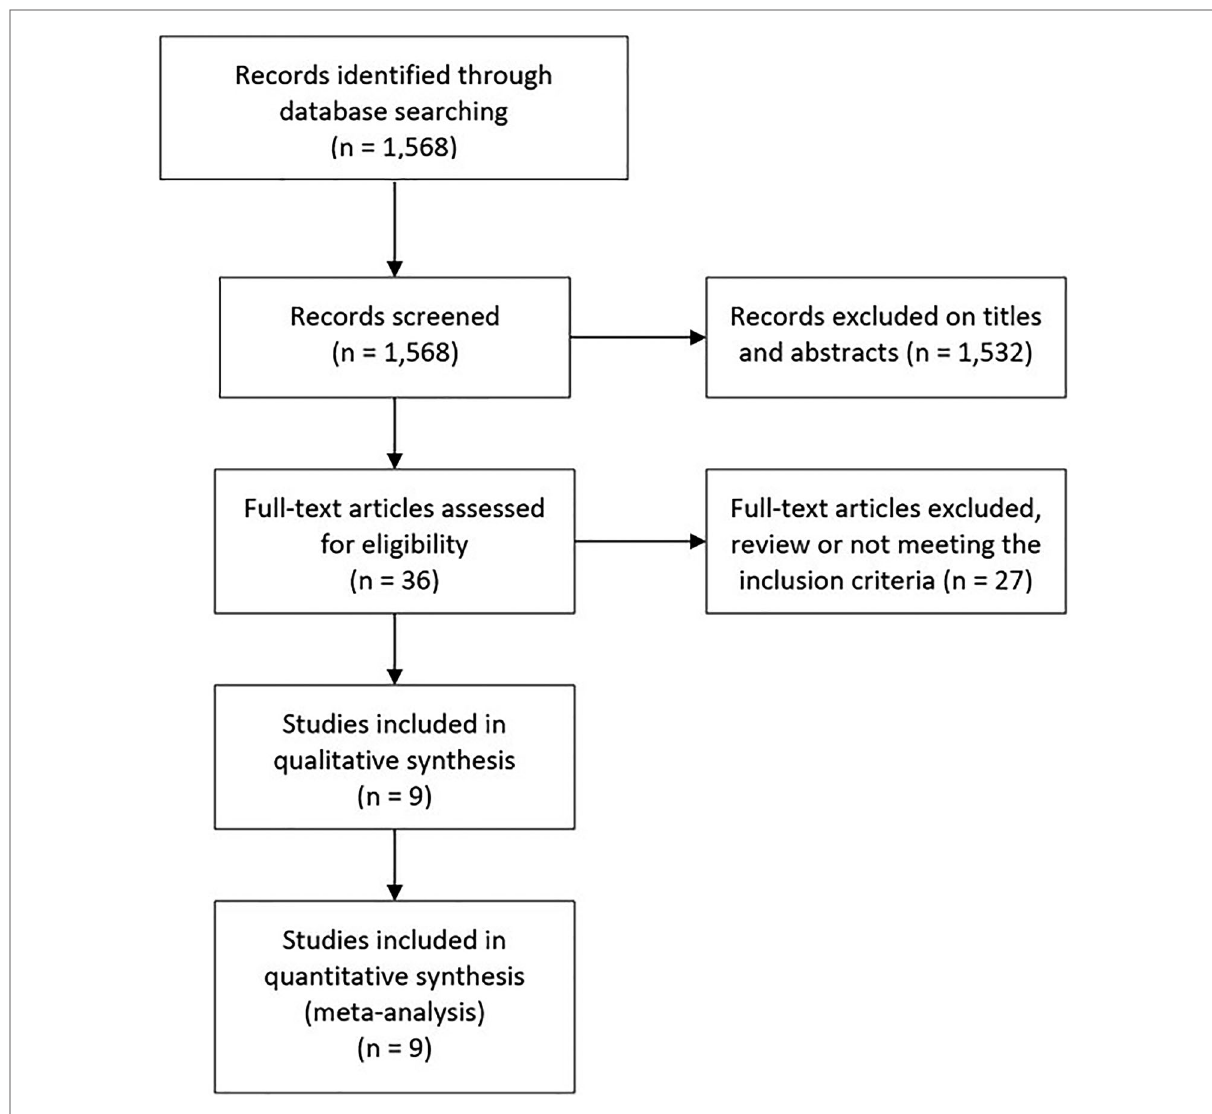
FIGURE 1 The fl ow-diagram showing the selection process of eligible studies for